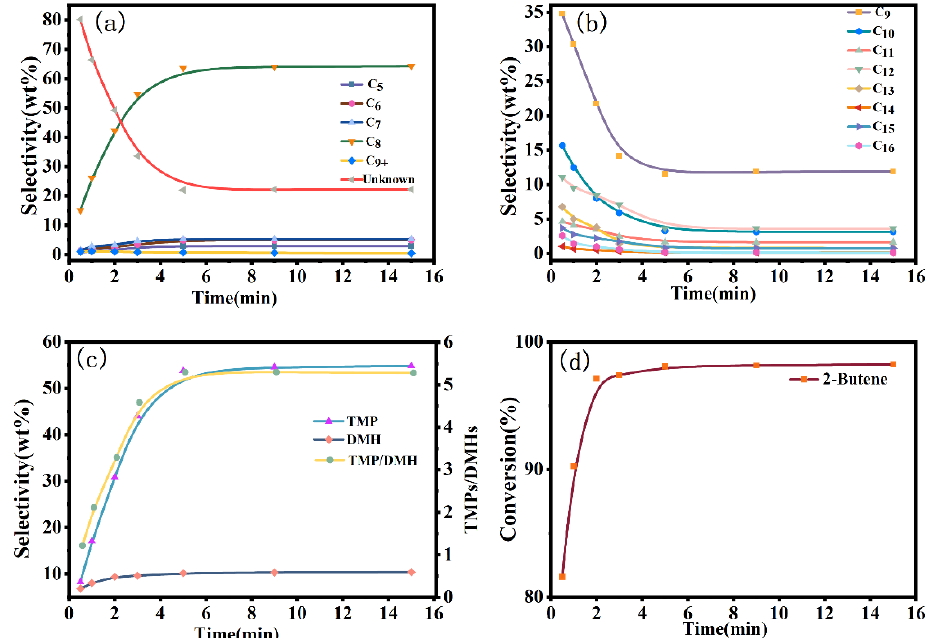
Figure 2. ( a ) Variation of the reaction product selectivity with time. ( b ) Variation of the C 9+ selectivity with time. ( c ) Variation of the C 8 and TMPs/DMHs values with time. ( d ) Variation of the 2-butene conversion with time. (H 2 SO 4 volume = 30 mL, I/O = 10:1, A/H = 1.0, T = 7 °C, stirring speed = 1300 rpm).